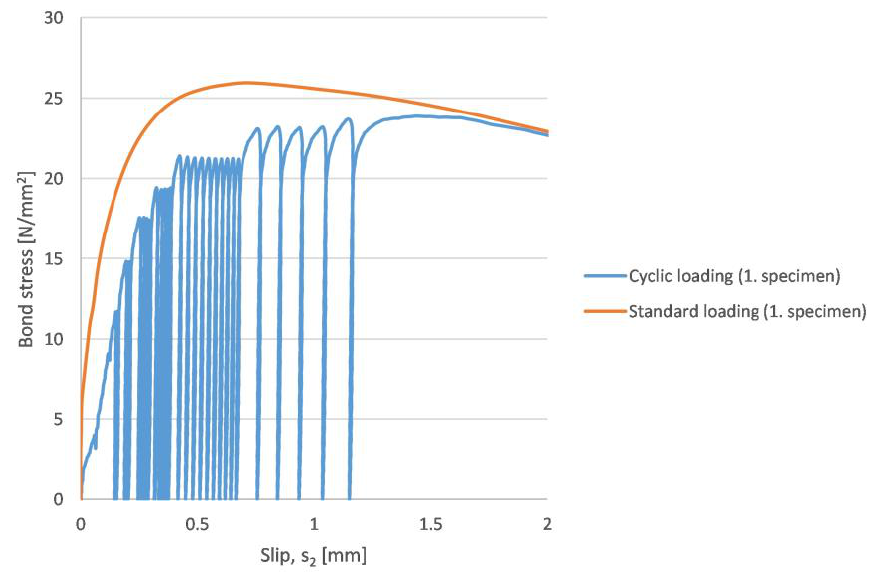
Figure 15. Comparison of standard and cyclic bond stress vs. slip of NWAC.